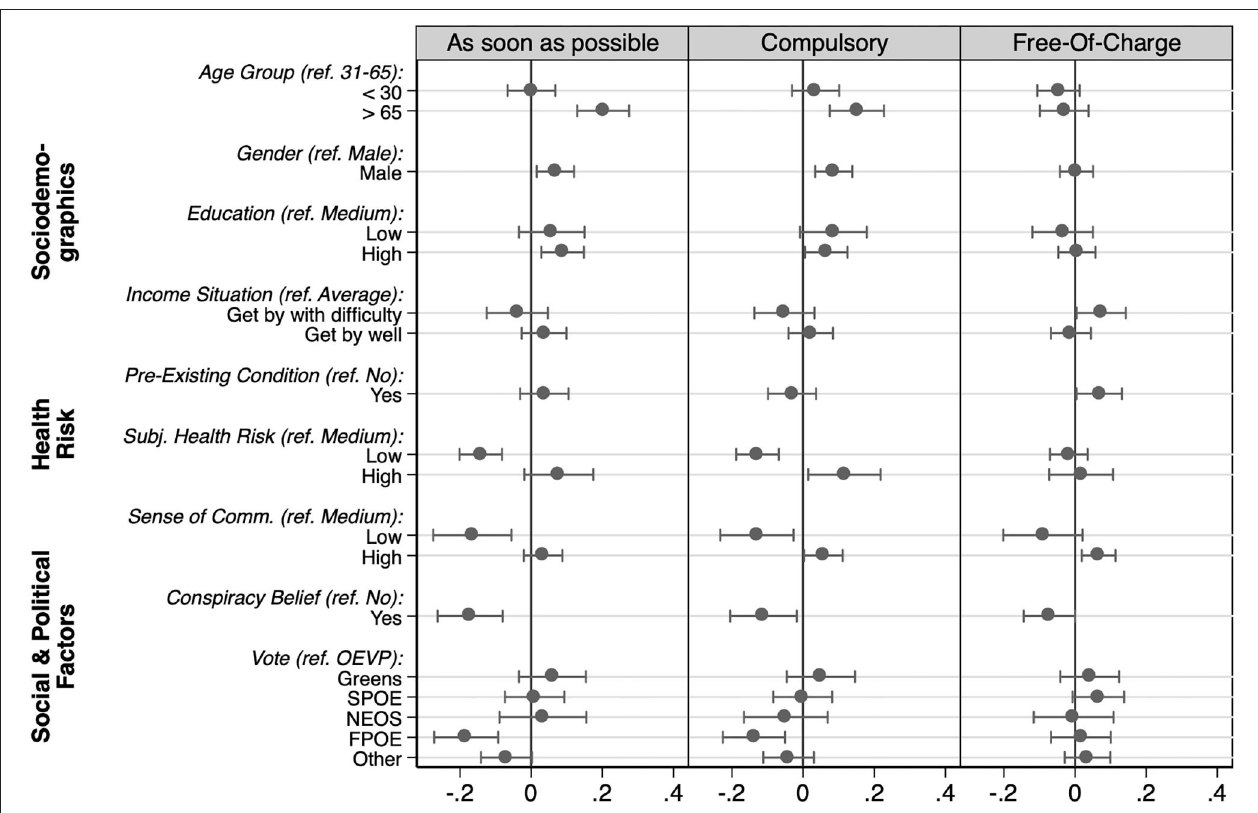
FIGURE 3 | Multivariate analysis. Displayed are the unstandardized coefficients from OLS regression alongside 95% confidence intervals. Each model includes all listed predictors simultaneously ( N = 1,301). The corresponding estimation tables are included in Appendix B .